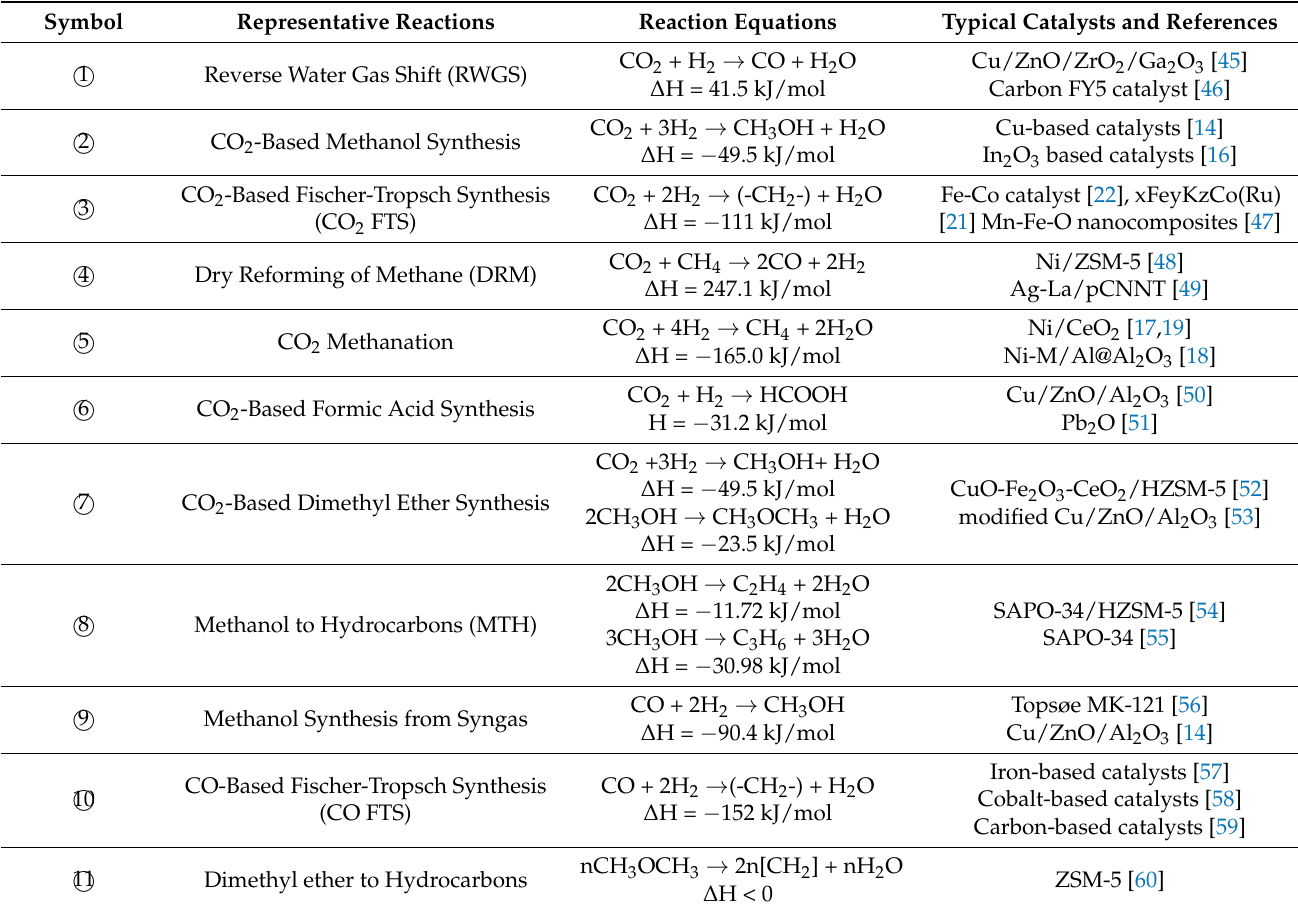
Table 1. Detailed reactions shown in Figure 2.